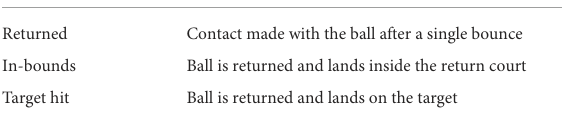
TABLE 1 Serve number, type, location, and velocity characteristics. TABLE 2 Tennis task serve return